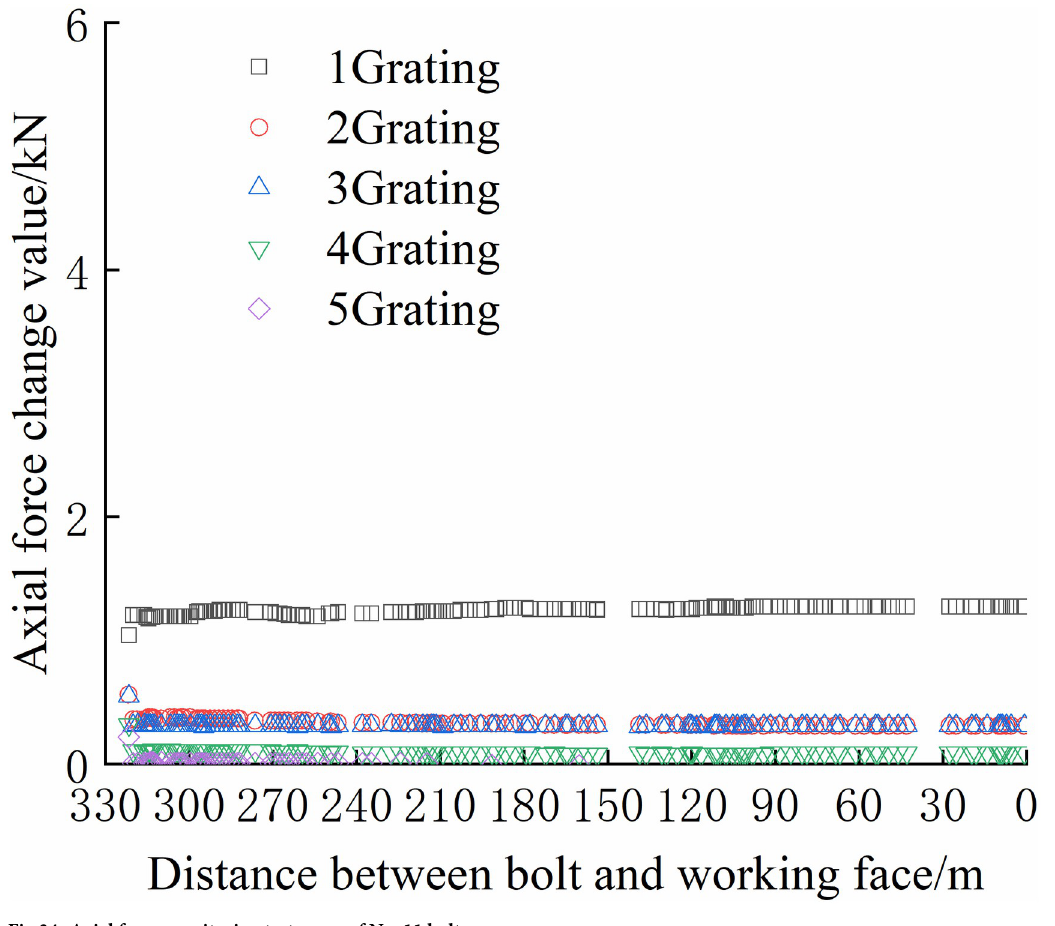
Fig 34. Axial force monitoring test curve of No. 11 bolt.